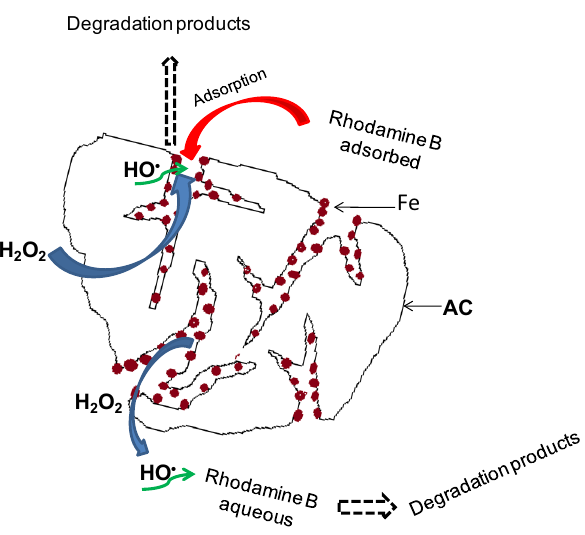
Fig. 13 Mechanism of Rhodamine B degradation using a heterogene- ous catalyst in the presence of H 2 O